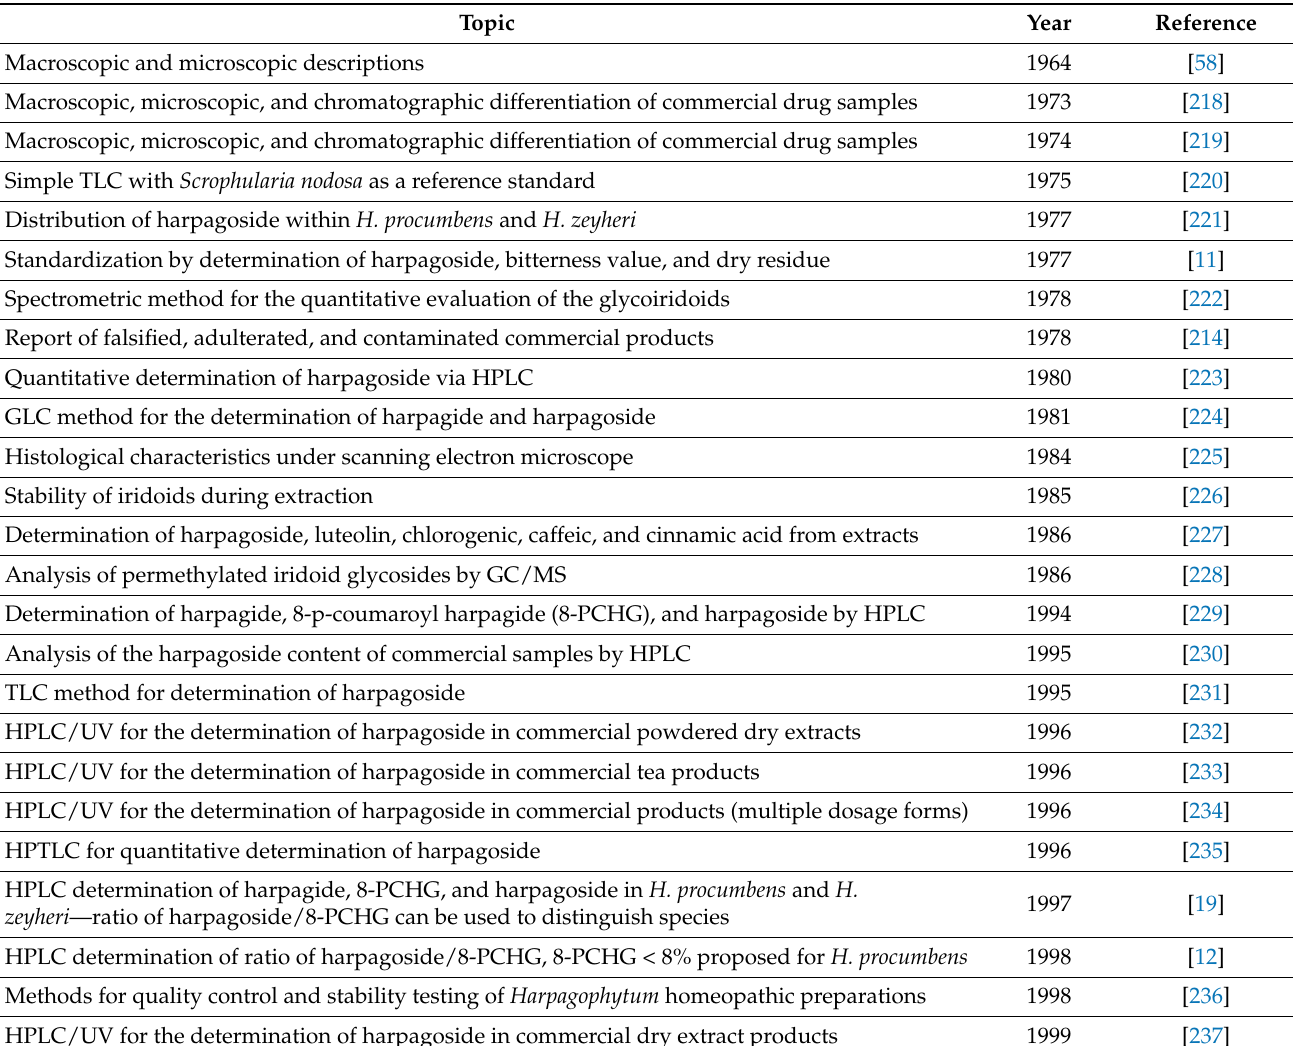
Table 3. Analytical methods and methods of quality